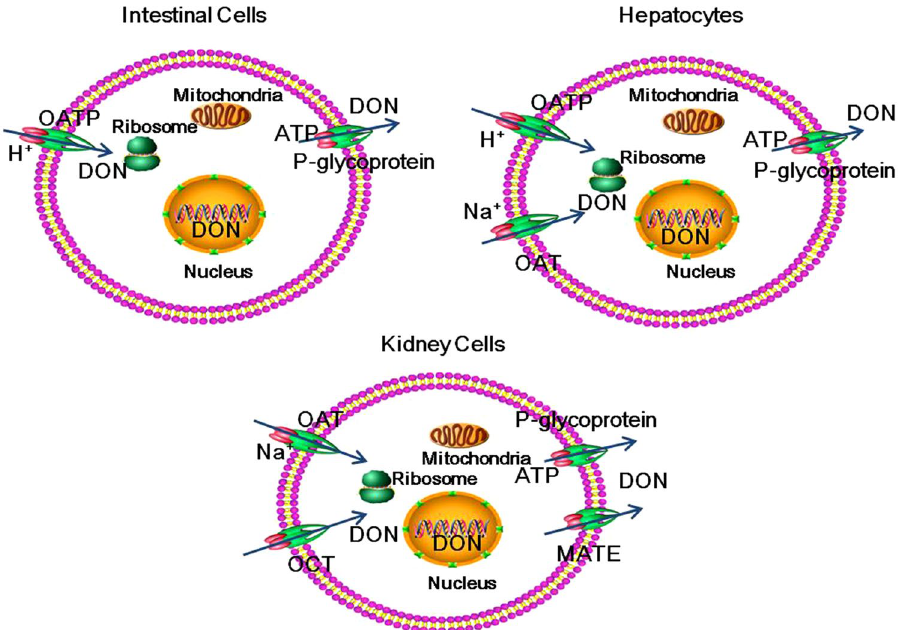
Figure 5. Postulated mechanisms of DON transport in mammalian cells. DON uptake and efflux is carrier- mediated and energy-dependent. P-glycoprotein is the major efflux transporter. OATPs, OATs and OATPs, and OATs and OCTs are the major uptake transporters of DON in intestinal cells, hepatocytes and kidney cells, respectively. Abbreviations: OATs, organic anion transporters; OCTs, organic cation transporters; OATPs, organic anion transporting peptide; MATEs, multidrug and toxin extrusion